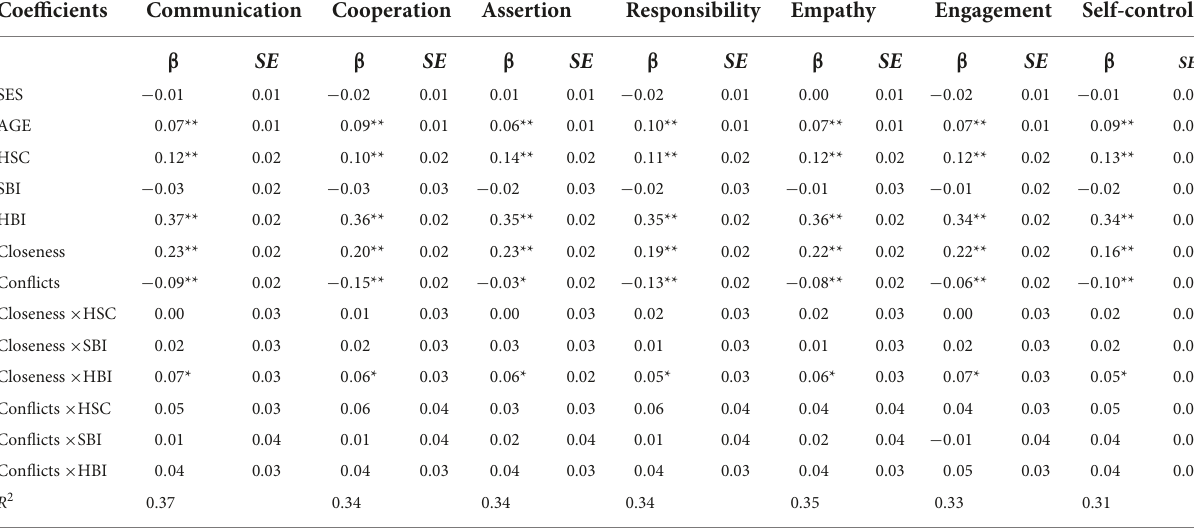
TABLE 3 Standardized coefficients from multivariate regression